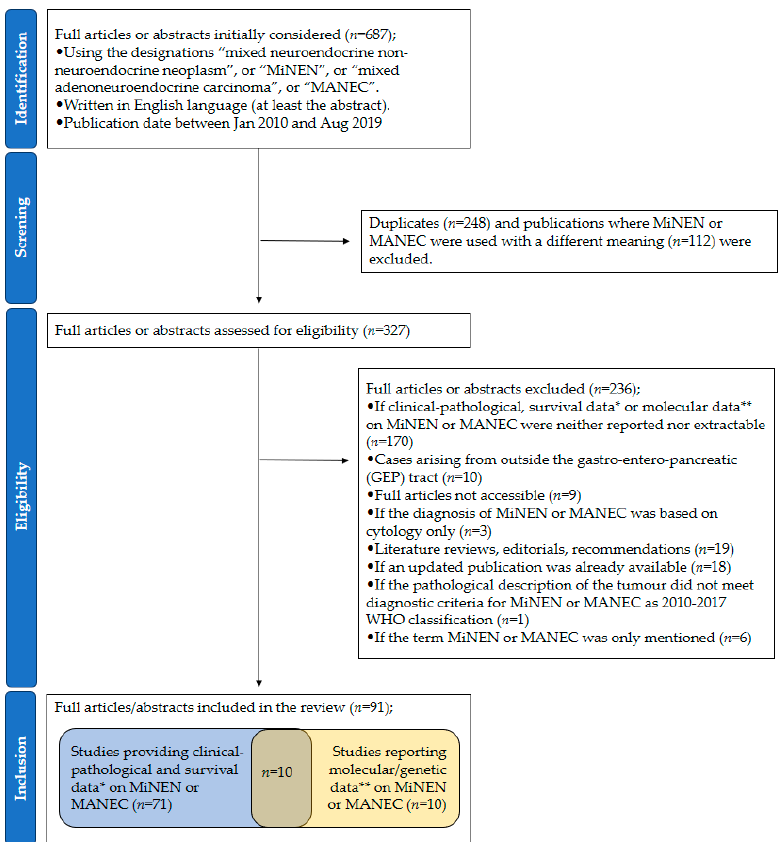
Figure 1. PRISMA flow diagram of study selection. PRISMA = Preferred Reporting Items for Systematic Reviews and Meta-Analyses; n = number of studies; MiNEN = mixed neuroendocrine non-neuroendocrine neoplasm; MANEC = mixed adenoneuroendocrine carcinoma; * follow-up time